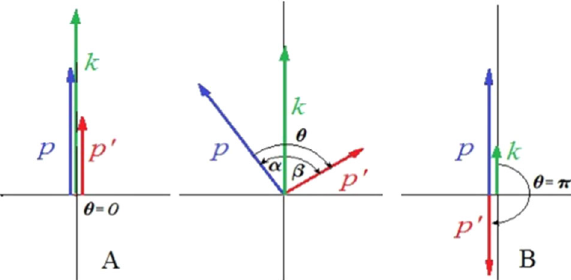
Fig. 3 Kinematics of the pair production showing the critical positions for p > p (cid:9) : A θ = 0, k = p + p (cid:9) , σ (cid:9) = σ, λ = 2 σ and B θ = π , k = p − p (cid:9) , σ (cid:9) = − σ, λ = 2 σ